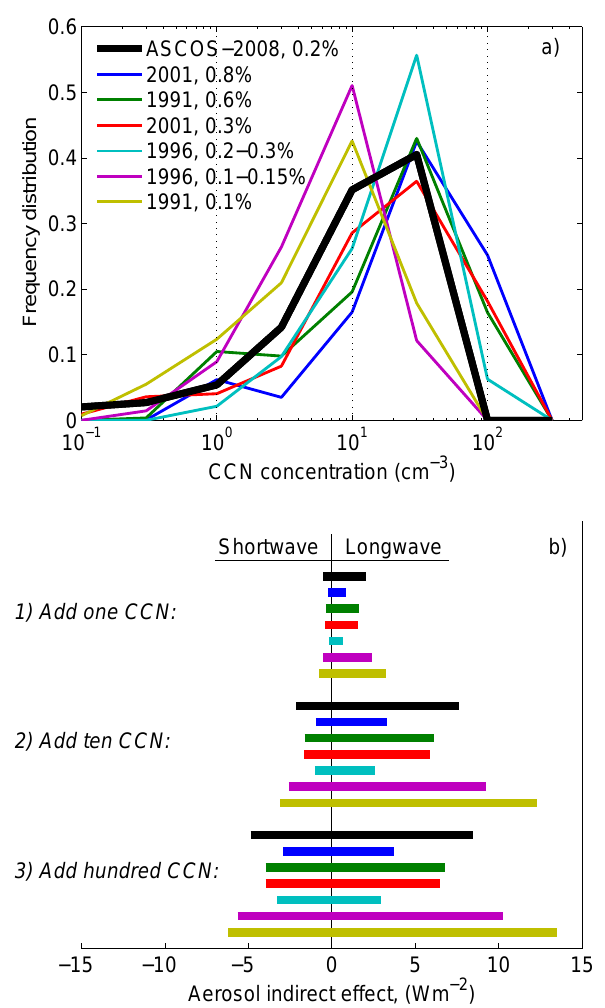
Fig. 6. Aerosol indirect effect impact estimates. Panel (a) displays frequency distributions of CCN from ASCOS and three earlier expeditions measured at different supersaturations as indicated in the legend. The expeditions were all conducted during the summer season in approximately the same area. (b) Impact estimates in three scenarios of changes to the CCN distributions under conditions found during ASCOS. The estimates are sorted according to applied supersaturation.